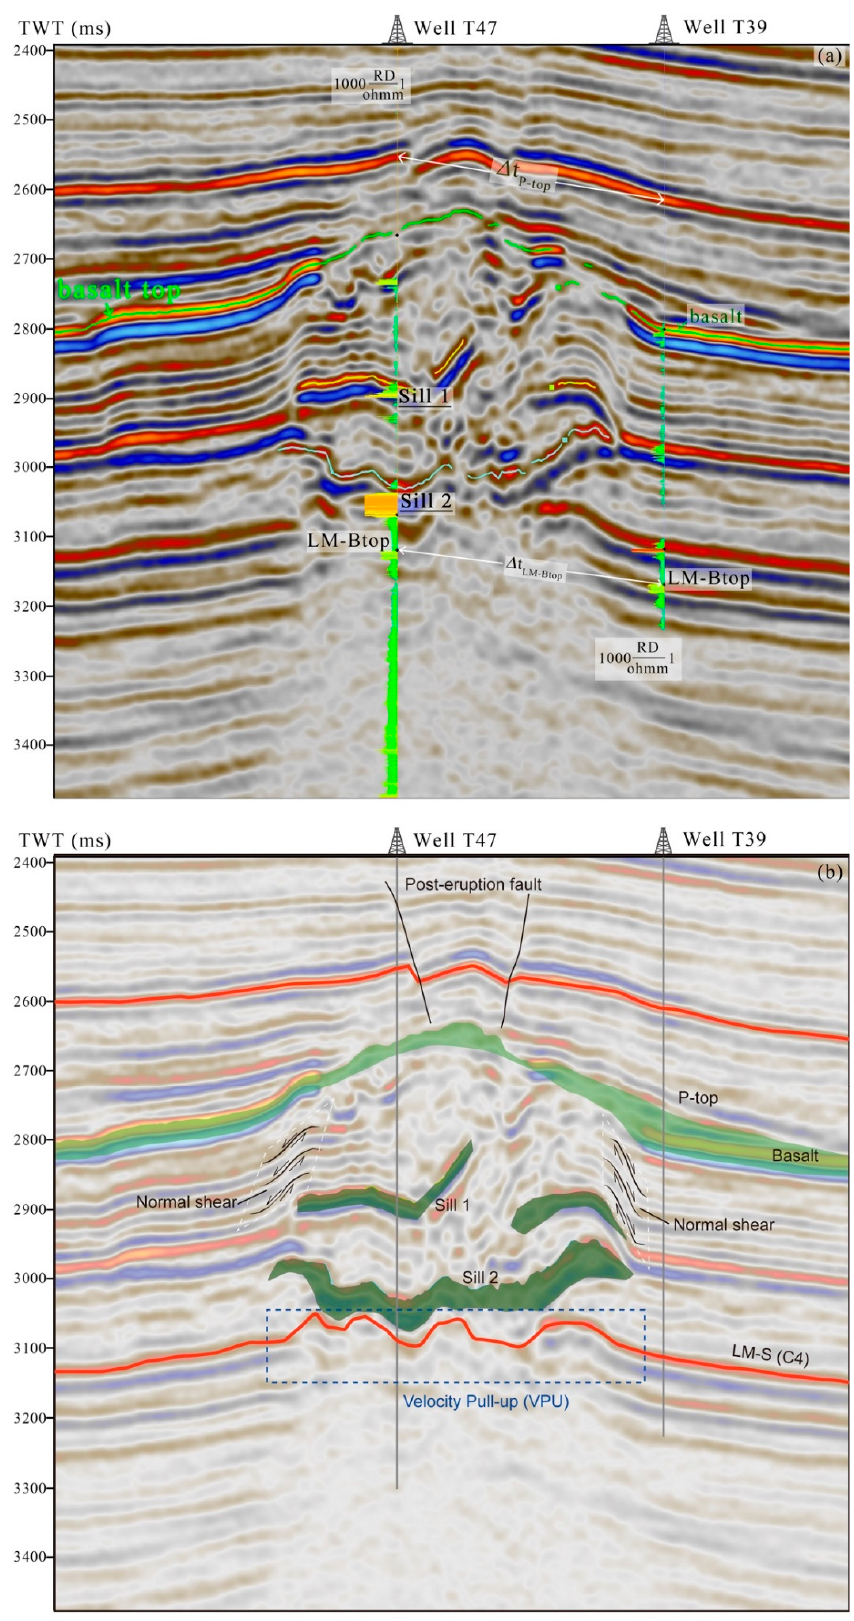
Figure 6. ( a ) Seismic profile crossing wells T47 and T39. ( b ) Interpretation sketch of the seismic profile.